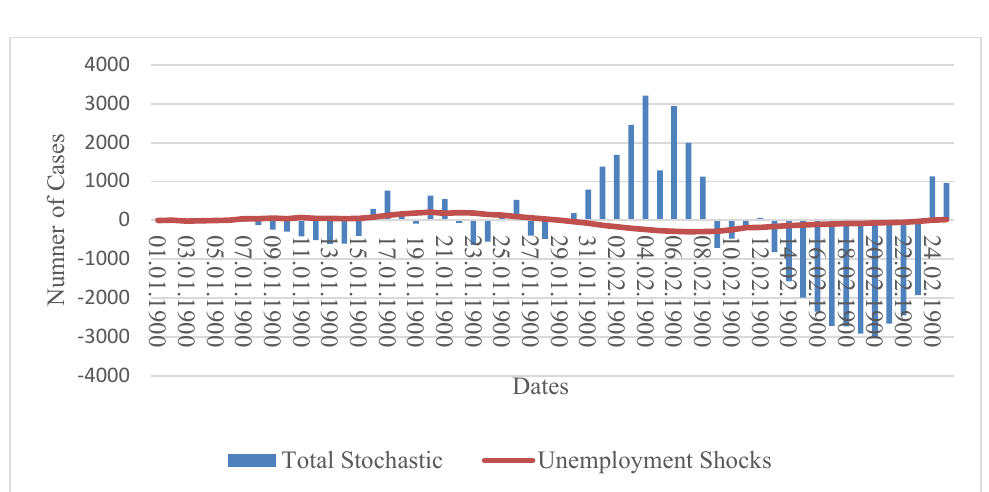
Fig. 5. Historical decomposition of the Covid-19 transmission levels.